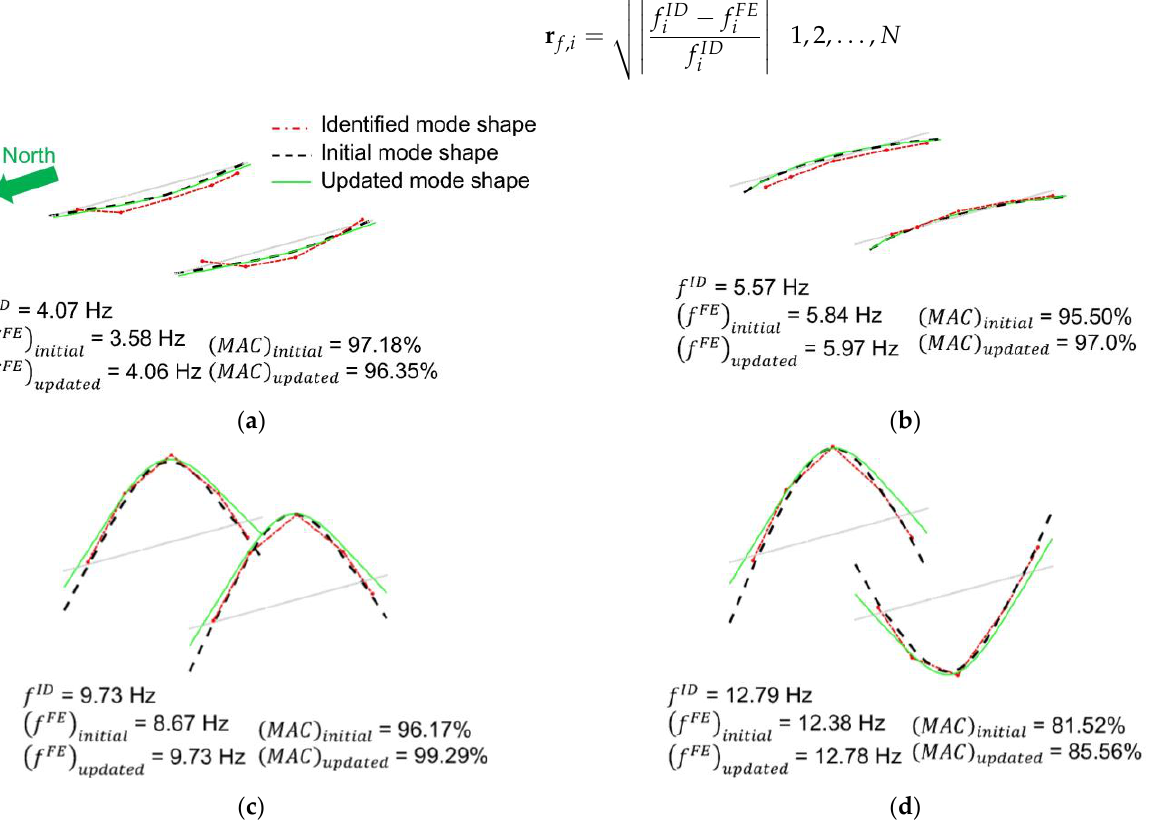
Figure 9. Comparison between identified, initial, and updated modal properties: ( a ) first lateral mode, ( b ) second lateral mode, ( c ) first vertical mode, and ( d ) second vertical mode. In the above equation, the terms f ID and f FE are the modal frequencies of the i th i i identified and FE-predicted modes. The term MAC i is defined as follows: parameters of the FE model [24,61]. In this process, an objective function, 𝑔(𝛉) , is defined